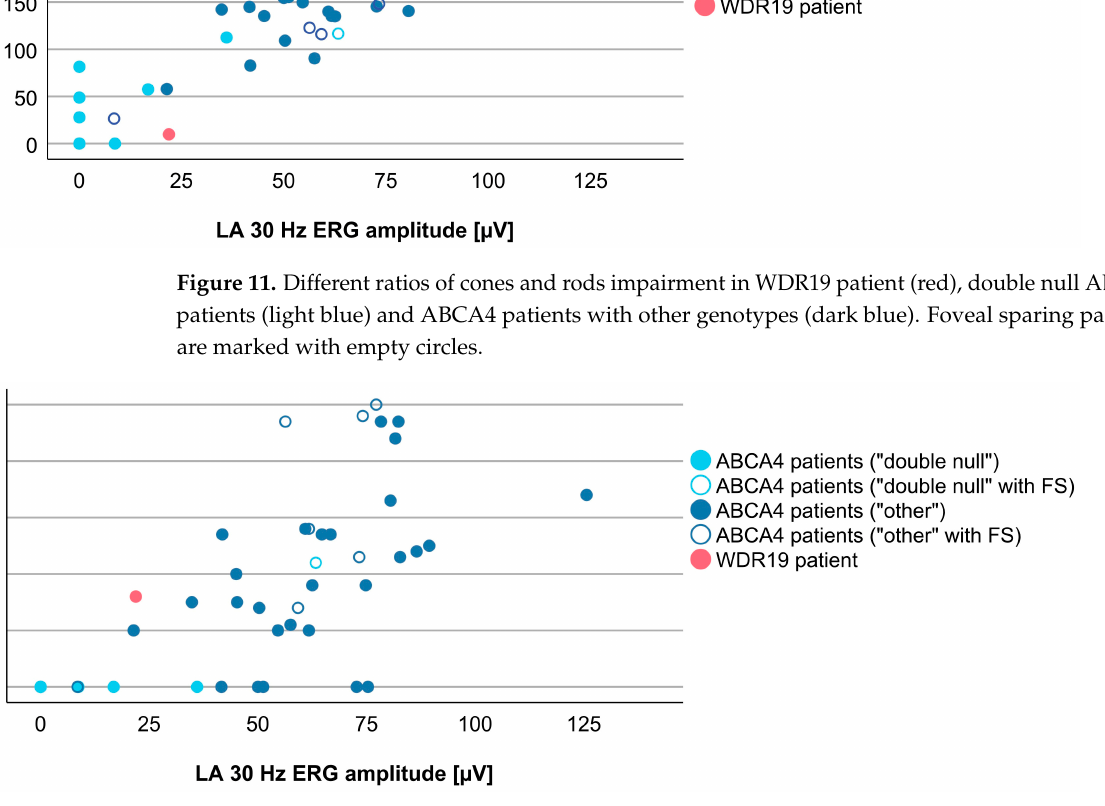
Figure 13. Different ratios of RPE and photoreceptor impairment in WDR19 patient (red), double null ABCA4 patients (light blue) and ABCA4 patients with other genotypes (dark blue). For this analysis a limited number of “other” ABCA4 patients (only those harboring ABCA4 variant c.5714+5G>A (p.[=,Glu1863Leufs * 33]) was included (see Materials and Methods). 4. Discussion The study reports a detailed phenotypic analysis of a WDR19 patient with a Stagart- like phenotype. The patients’ phenotype was by and large undistinguishable from ABCA4-Stargardt disease; however, there were some atypical findings, notably the degree of foveal sparing and the relatively severe involvement of rod photoreceptors. 4.1. Genetic Considerations The presented patient harboured a previously reported heterozygous missense variant p.(Ser485Ile) and a novel heterozygous deletion c.(3183+1_3184-1)_(3261+1_3262- 1)del, encompassing exon 29 of the WDR19 gene. Single or multi exon heterozygous deletions in the WDR19 gene have previously been reported in patients with WDR19- related conditions [46]. To date, no patients with WDR19-associated Stargard-like phenotype have been reported to have candidate copy number loss/gain variants. Some pathogenic copy number variants encompassing single or multiexon deletion have been associated with WDR19-related conditions [46] (see also ClinVar database). We added reported copy number variants in the WDR19 gene in the Supplementary Table S1, which sums reported pathogenic variants in the WDR19 gene. Variant p.(Ser485Ile) has been reported as compound heterozygous with WDR19 c.1031A>G; p.(His344Arg) in a family with two affected individuals with Stargardt-like phenotype [34]. It is likely that variants in our WDR19 patient are the cause of the disease, as the Stargardt-like phenotype has